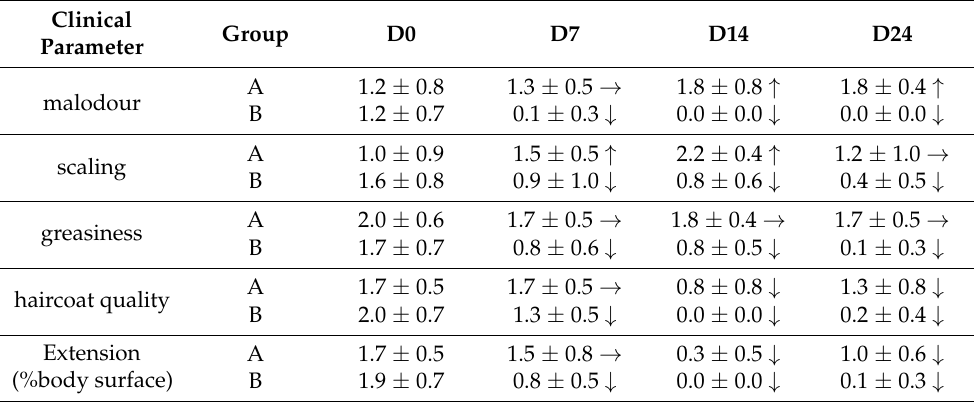
Table 4. Details of the clinical scores (mean ± standard deviation) in dogs with keratinization disorders that were washed in plain water (group A) or received DOUXO ® S3 SEB shampoo and mousse (Ceva Sant é Animale, France) (group B) at different time points during the study. The arrow indicates the trend for each parameter at each time-point, compared to D0.